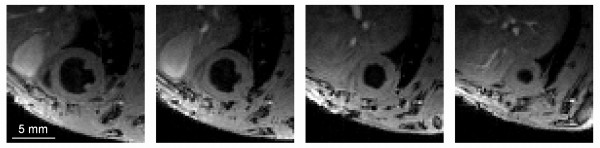
3D black-blood retrospectively triggered CINE images used for determination of wall thickening. Images from left to right represent different slices through the heart towards the apex (movie provided in Additional File 1).